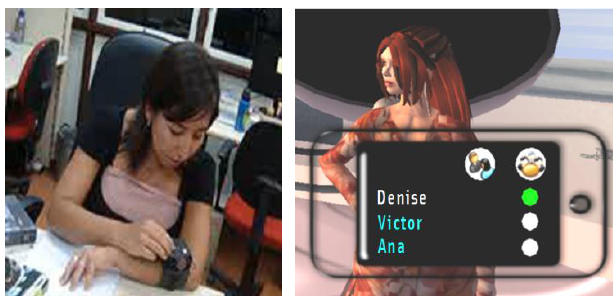
Figure 8. Meeting attendance confirmation using the bracelet in the real world and by selecting a button on a HUD in the virtual